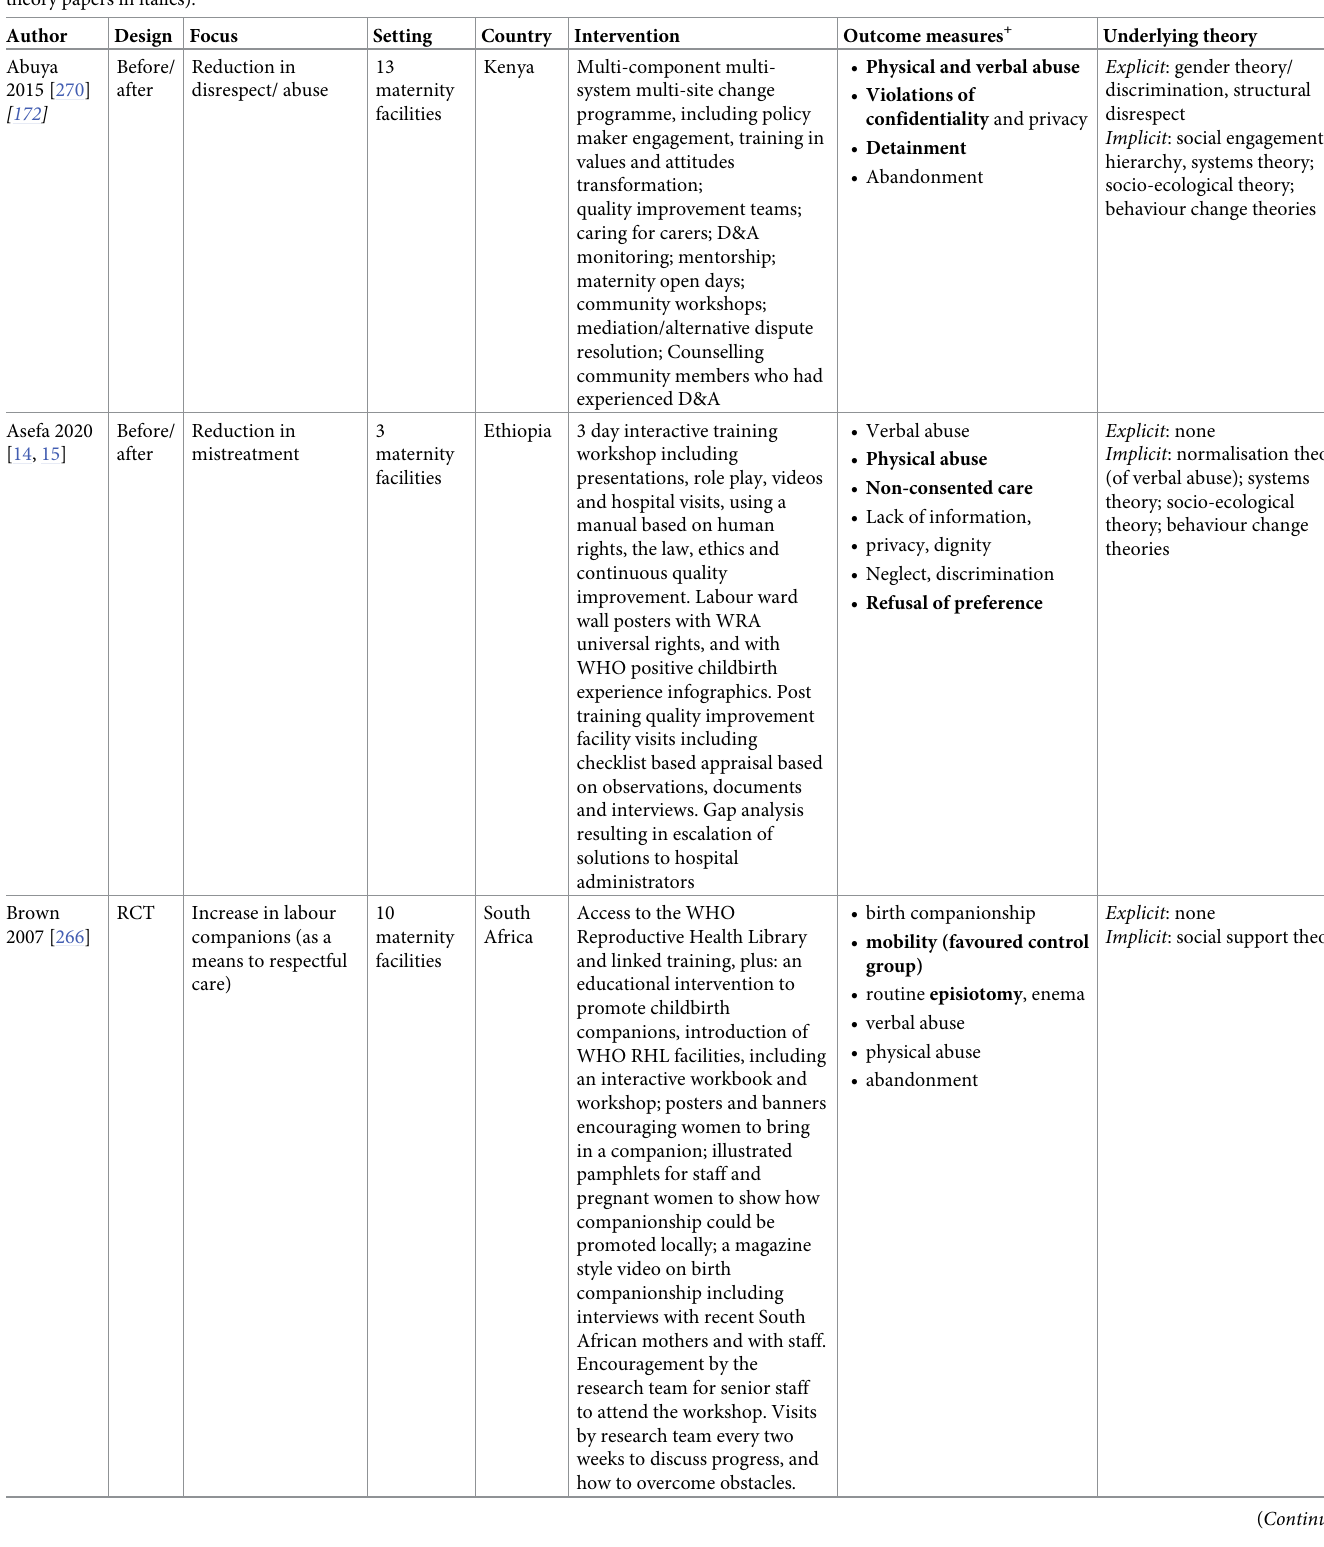
Table 6. Characteristics of published studies of respectful care interventions in maternity services. (outcomes that improved with the intervention in bold: associated theory papers in